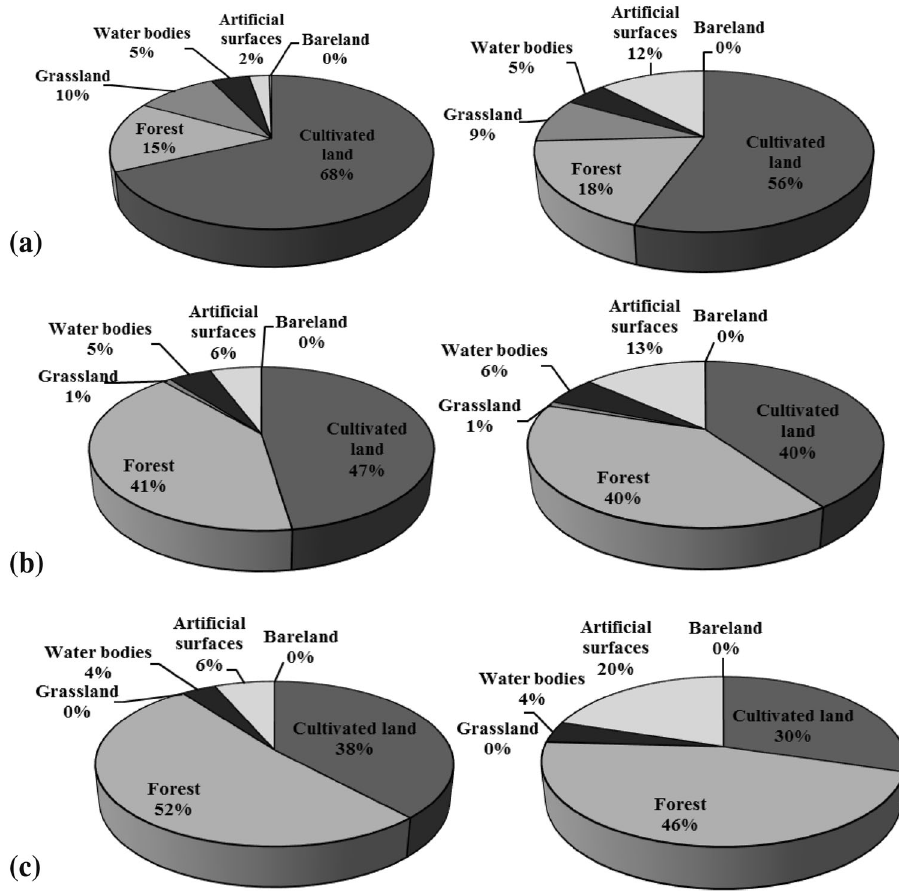
Fig. 5 Proportions of LULC classes in the UpYong ( a ), MidHeng ( b ), and DownZhu ( c ) catchments in the 1980s (left) and 2015